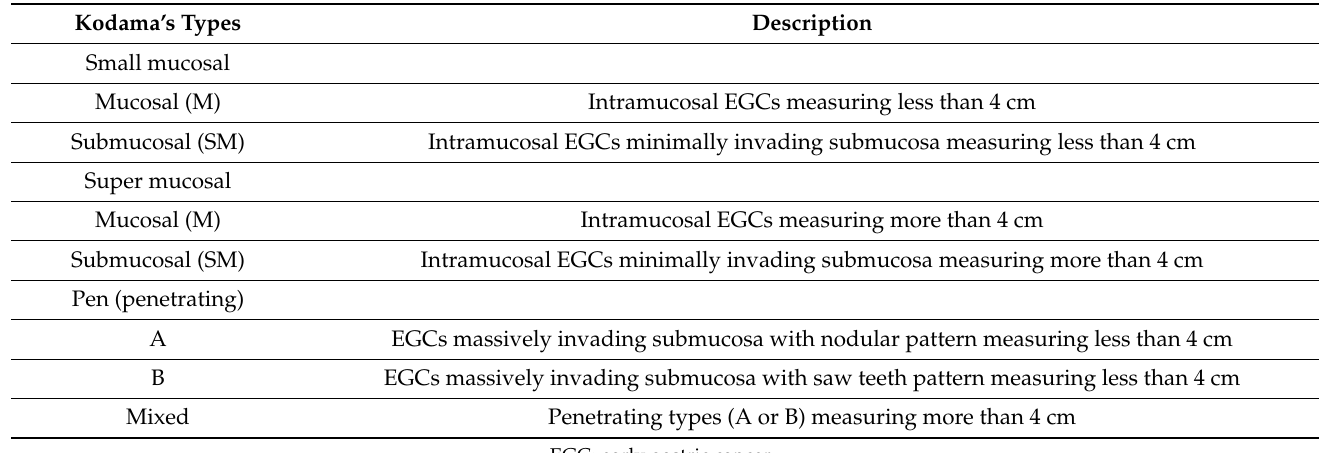
Table 1. Kodama’s